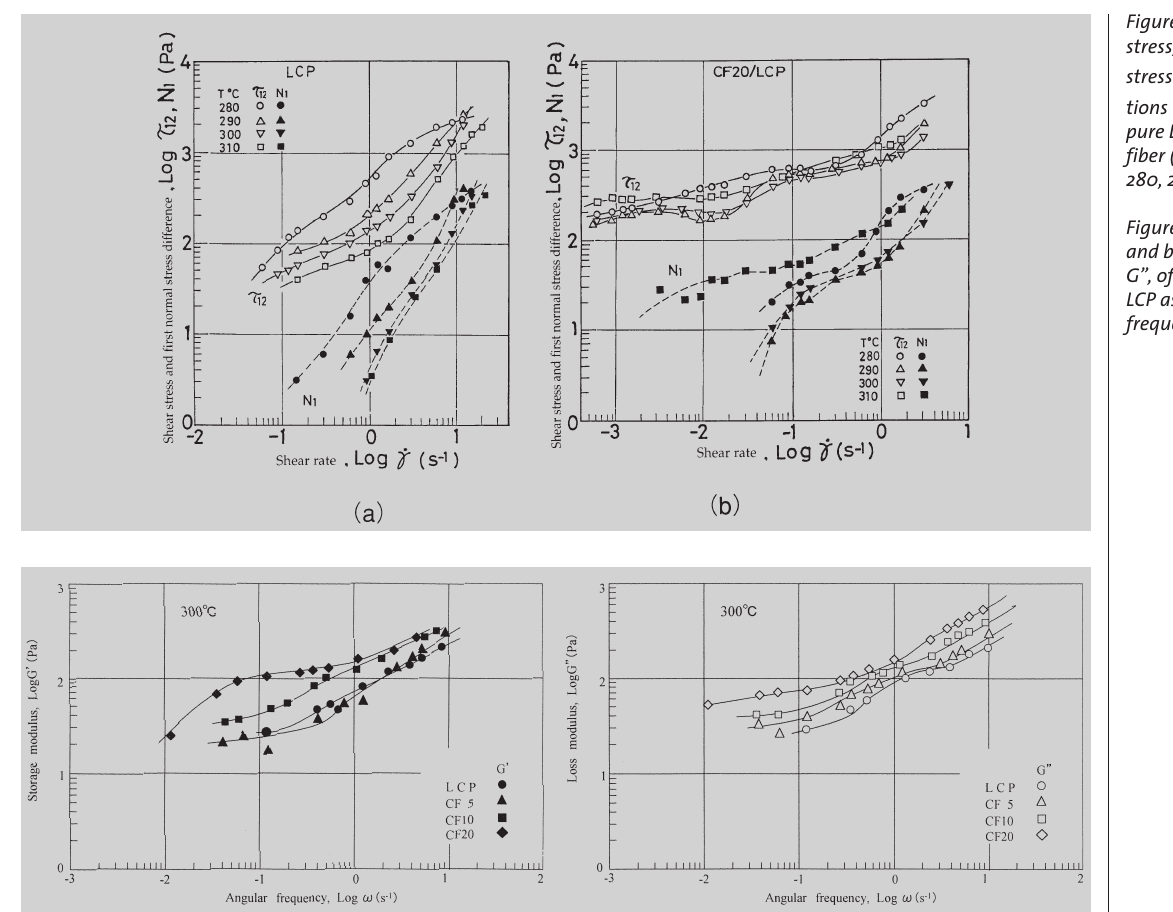
Figure 8 (above): Shear stress, t 12, and first normal stress difference, N1, as func- tions of shear rate, g · , for a.) pure LPC and b.) carbon fiber (CF20) compound at at 280, 290, 300 and 310˚C. Figure 9 (below): a.) Storage and b.) loss moduli, G’ and G”, of carbon fiber (CF) filled LCP as a function of angular frequency, w , at